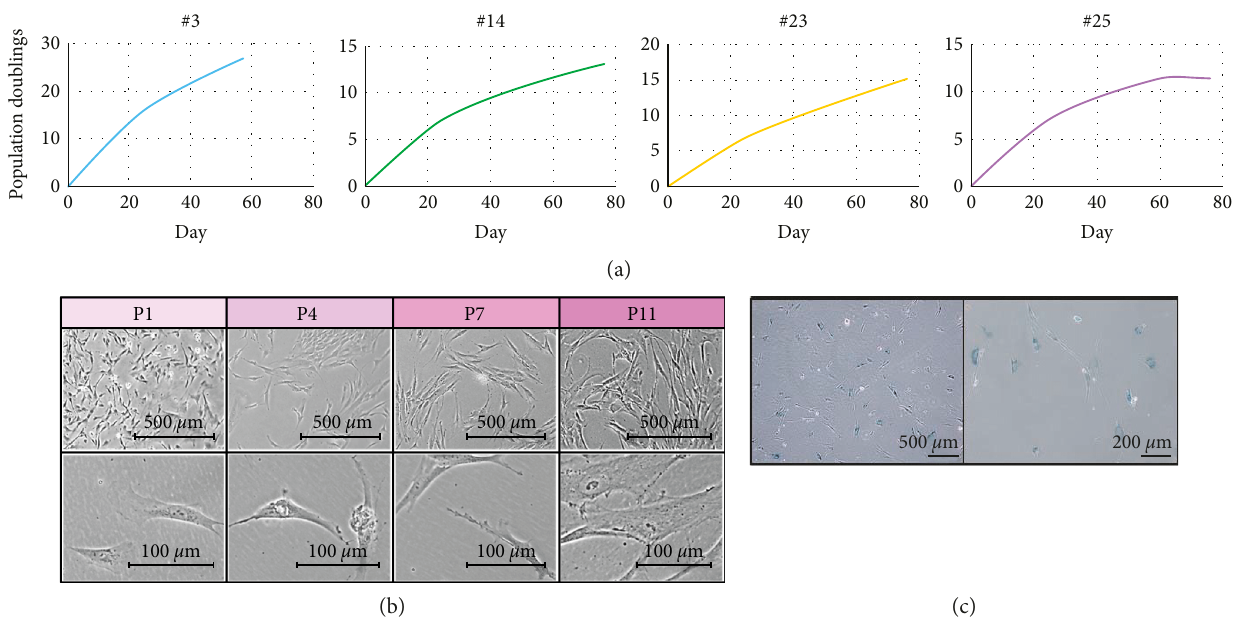
Figure 2: Characterization of mesenchymal stromal cells. (a) Growth curve of mesenchymal stromal cells (knst#3, #14, #23, #25). (b) Phase contrast photomicrography of mesenchymal stromal cells (knst#2: passages 1, 4, 7, and 11). (c) Senescence-associated beta-galactosidase stain (knst#3, passage 11).